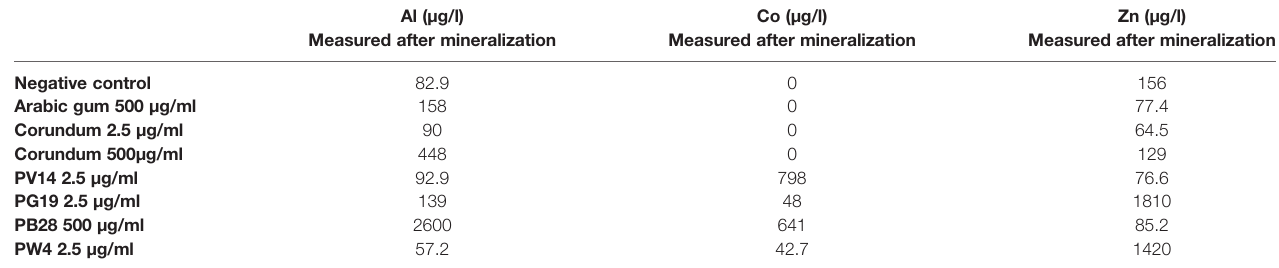
TABLE 1 | Metal analysis of the